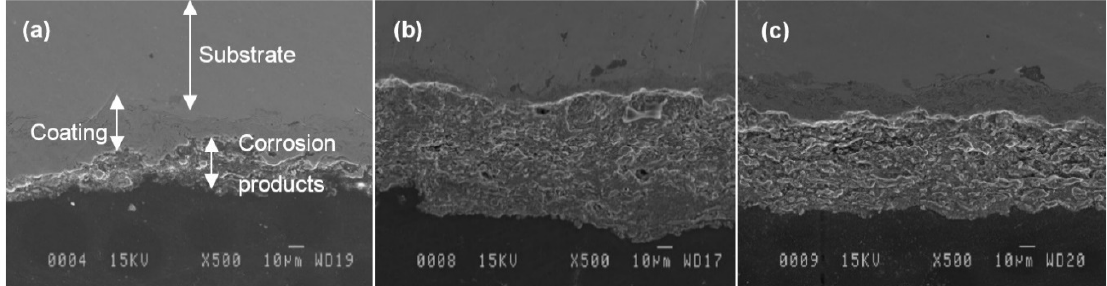
Figure 2. Cross-sectional SEM micrograph of the corrosion product layer formed on: ( a ) Fe 3 Al, ( b ) Fe 3 Al/TiC, and ( c ) Fe 3 Al-Cr/TiC after subjected to the potentiodynamic polarization test.